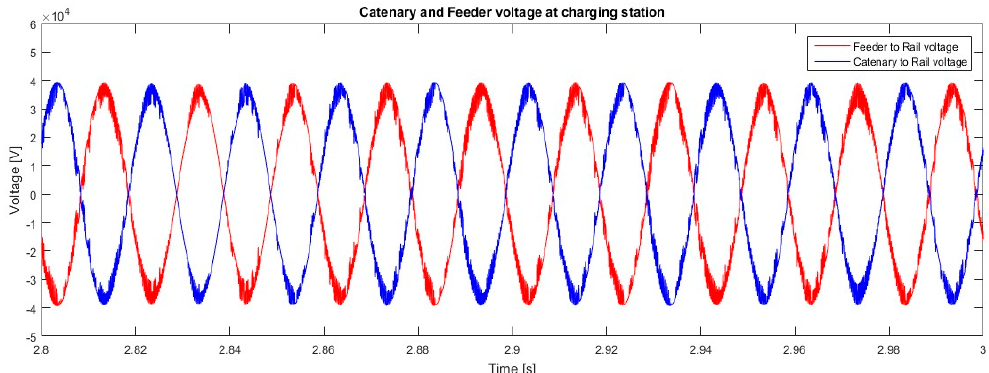
Figure 12. Feeder and catenary voltage due to the charging station presence.